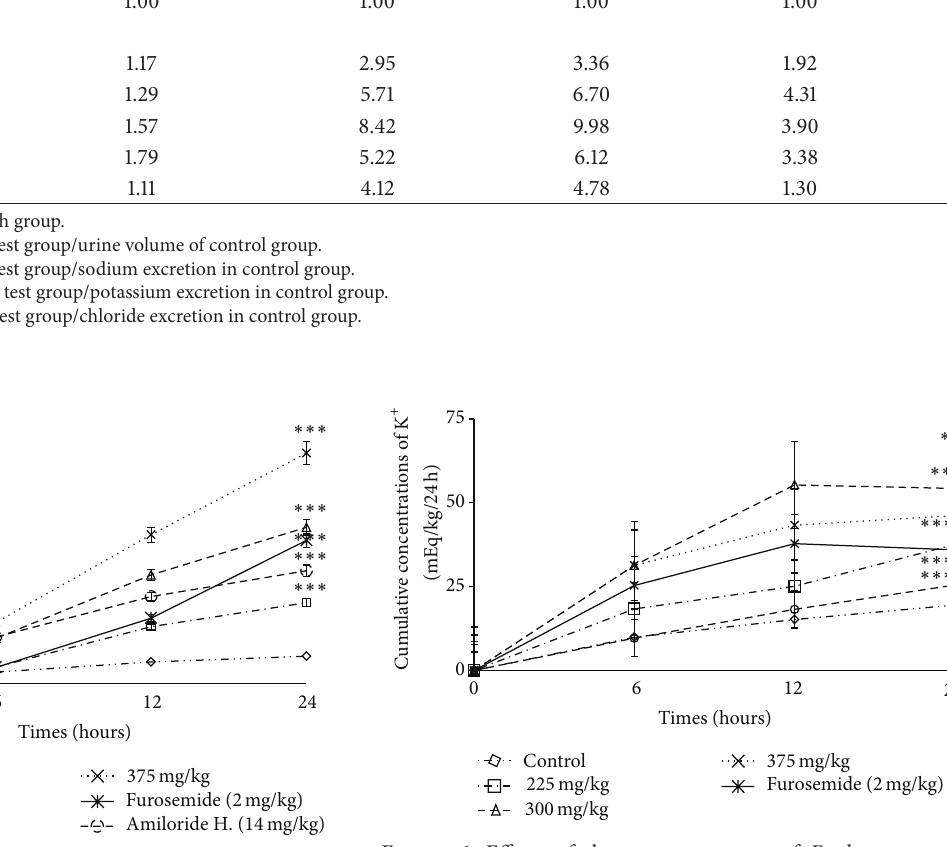
Table 3: Effects of the aqueous extract of F. glumosa on urine output index and electrolytic excretion index in 24 hours of urine collection. Drugs (mg/kg)